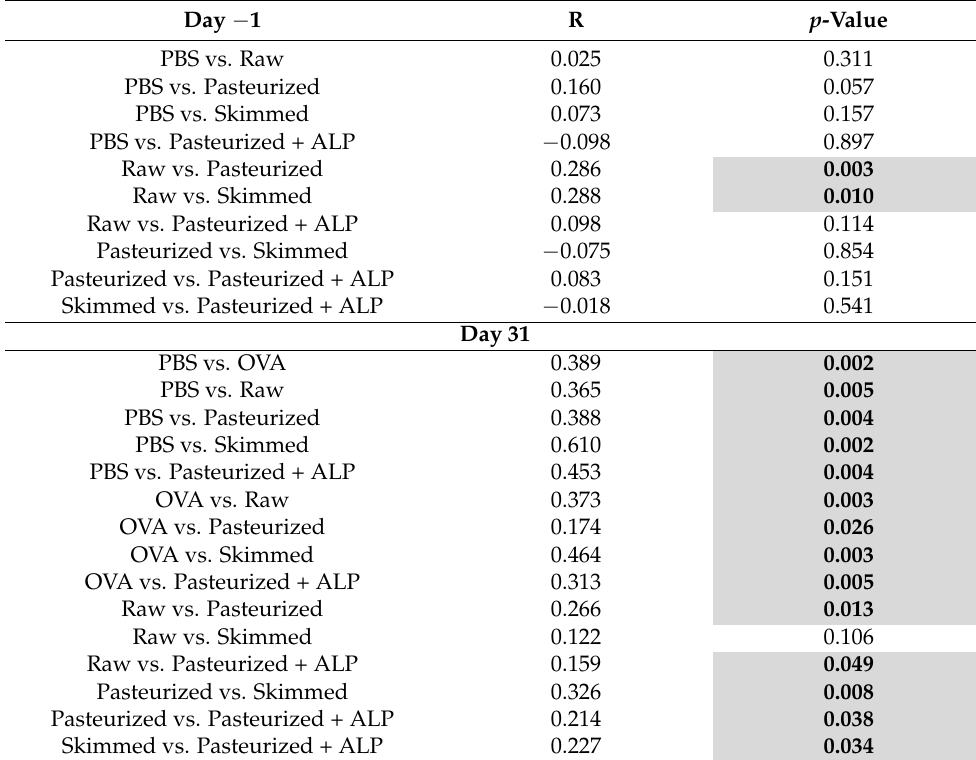
Table 1. Group analysis of similarity (ANOSIM) results for overall fecal microbiota compositions between control and experimental groups at the taxonomic level of genus. Day − 1 R p -Value PBS vs. Raw